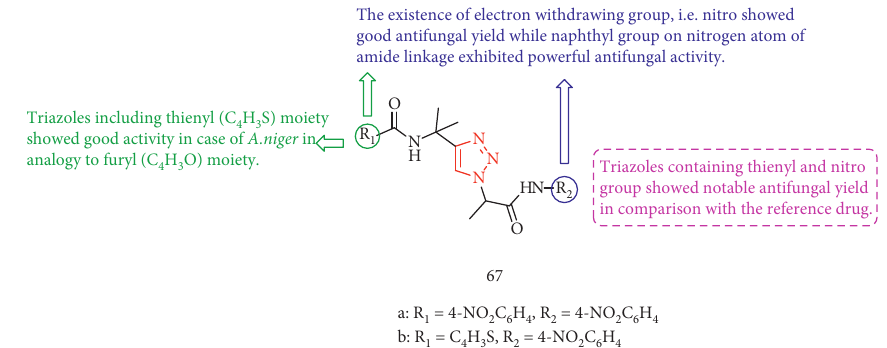
Figure 22: Chemical structure of 1,4-disubstituted 1,2,3-triazoles. strains.The against both the